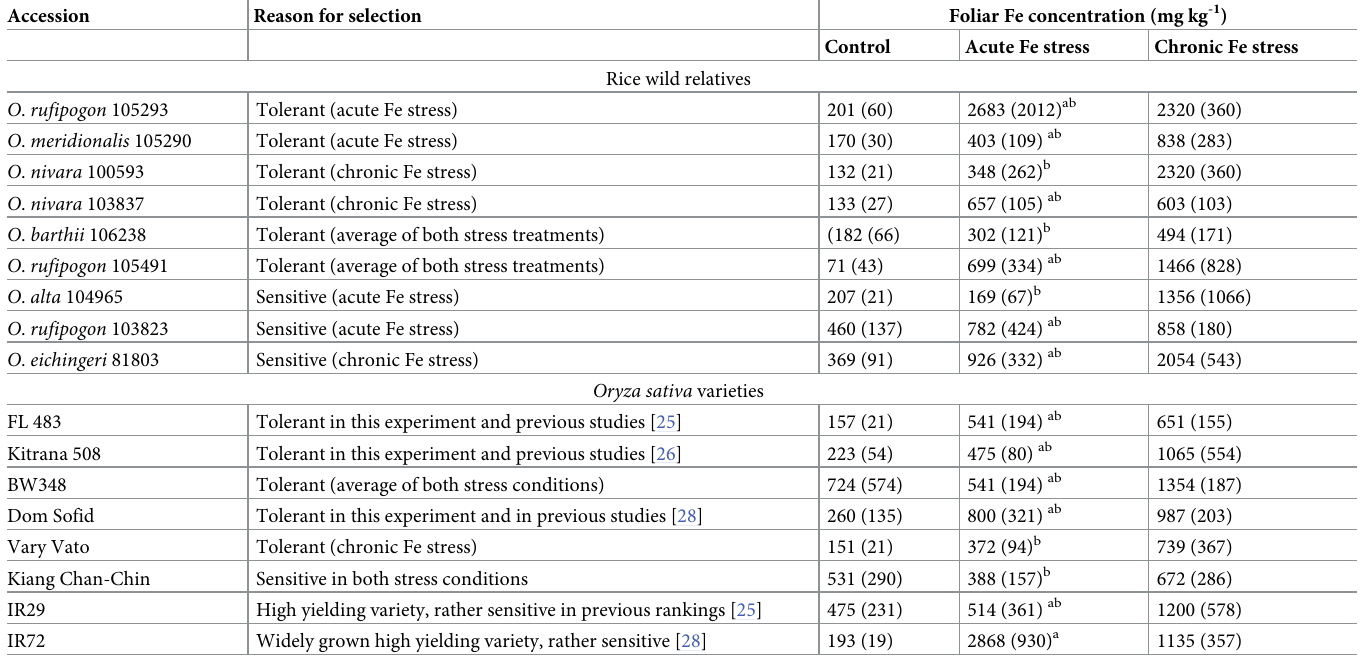
Table 2. Iron concentrations in leaves of selected genotypes sampled 16 weeks after transplanting.